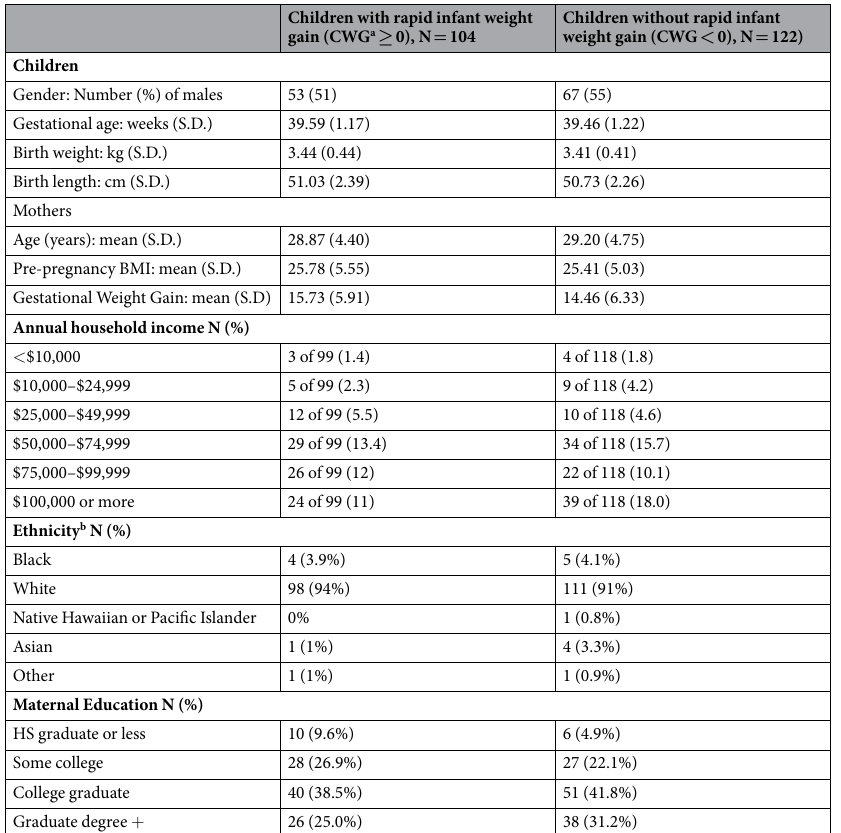
Table 1. Description of the study population. a CWG is conditional weight gain (see text for more details). b Ethnicity was